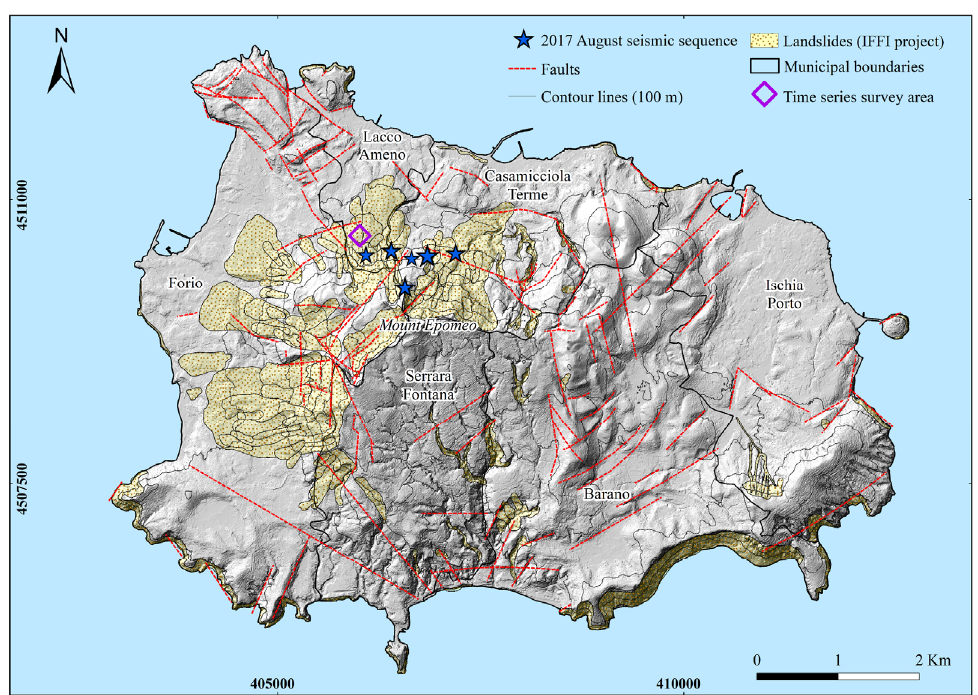
Figure 2. Hillshade relief of Ischia with the epicentres of the 2017 seismic sequence [9] and the area examined through the displacement time series analysis in addition to the municipalities and their limits, contour lines, faults [10] and landslides phenomena mapped within the island (IFFI landslides inventory). Geographic coordinate system is UTM 33N, WGS 84.